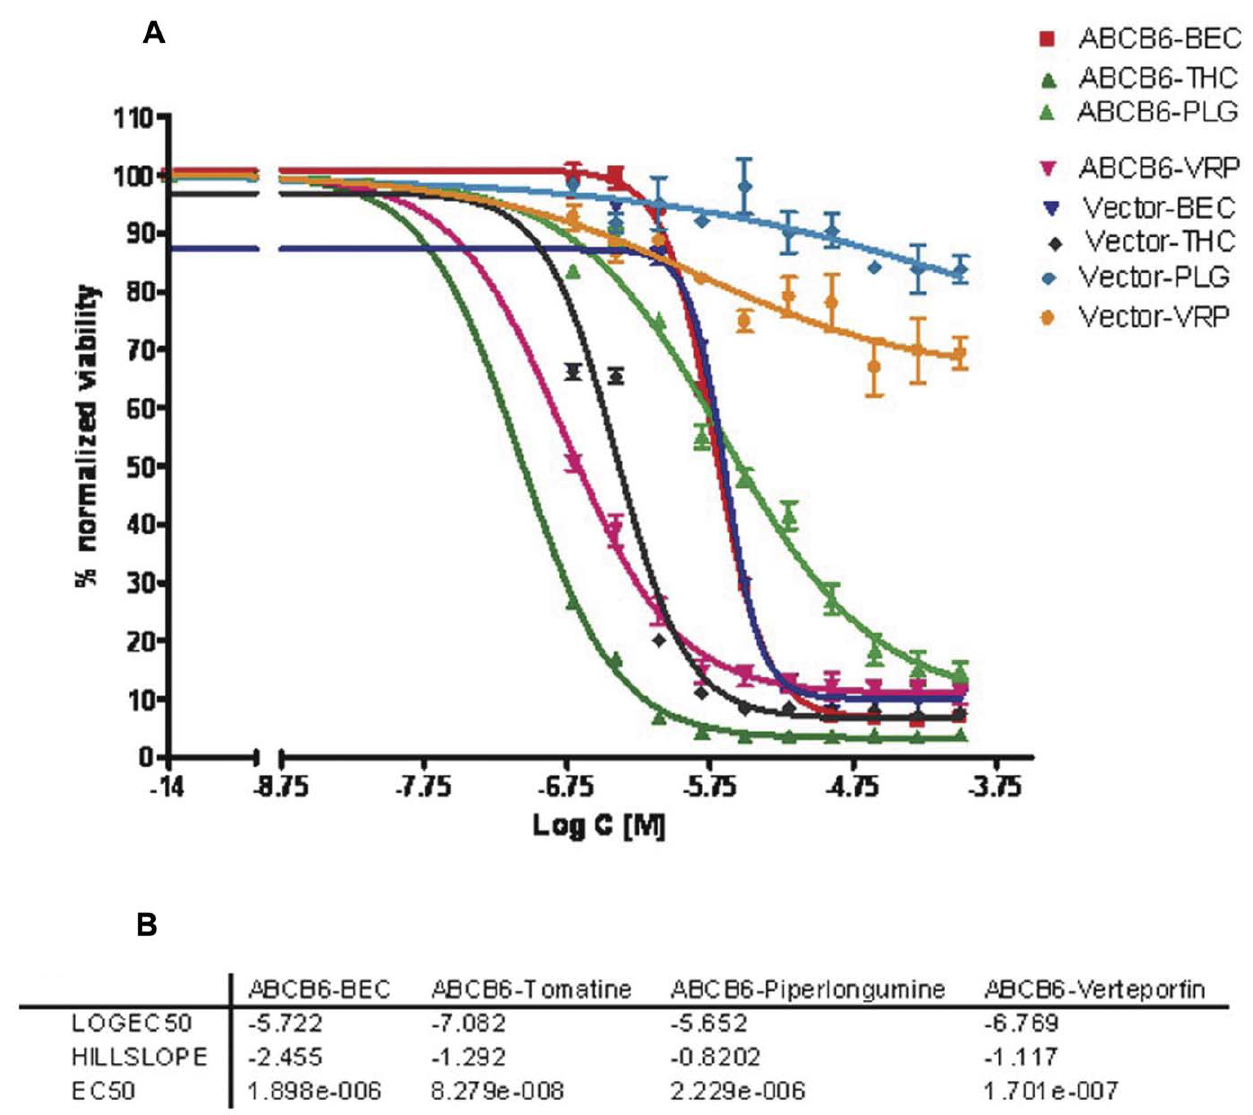
Figure 3. Toxicity profile for ABCB6 overexpressing and vector cells treated with the four compounds identified in the primary HTS screen. (a) Dose dependent toxicity of the four compounds in ABCB6 overexpressing and vector cells. (b) EC 50 value for each of the compound and their corresponding hill slope values. Results represent mean + / 2 SD with n=3.